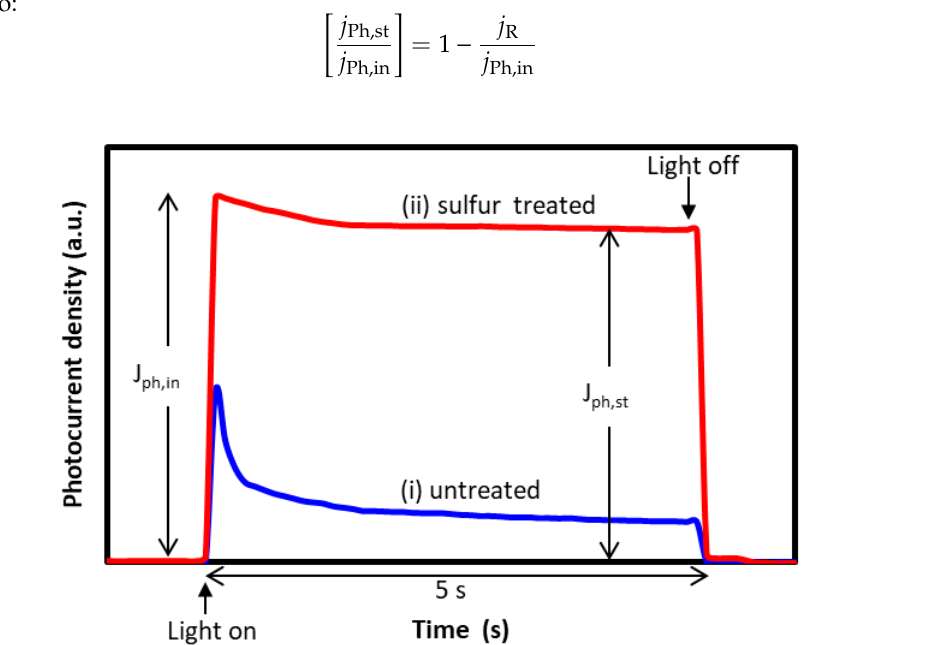
Figure 5. Photocurrent transient measurements of (i) n -Cu 2 O/ p -Cu 2 O homostructure and (ii) sulfur-treated n -Cu 2 O/ p -Cu 2 O homostructure.